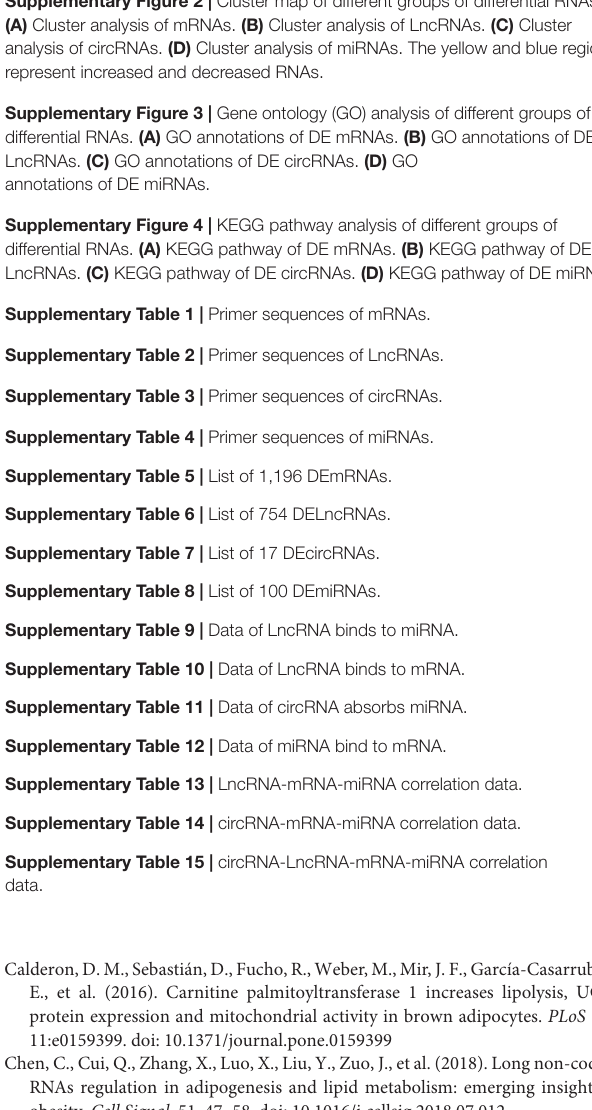
RNAs; gray points represent not significantly expressed RNAs in the volcano plots. (G–I) Expression profiles of miRNAs (M1 vs. P1, M2 vs. P2, M3 vs. P3). Blue points represent down-regulated RNAs; yellow points represent up-regulated RNAs; gray points represent not significantly expressed RNAs in the volcano plots. X-axis: Fold change log2 ratio of RNAs. Y-axis: false discovery rate values (-log10 transformed). Supplementary Figure 2 | Cluster map of different groups of differential RNAs. (A) Cluster analysis of mRNAs. (B) Cluster analysis of LncRNAs. (C) Cluster analysis of circRNAs. (D) Cluster analysis of miRNAs. The yellow and blue regions represent increased and decreased RNAs. Supplementary Figure 3 | Gene ontology (GO) analysis of different groups of differential RNAs. (A) GO annotations of DE mRNAs. (B) GO annotations of DE